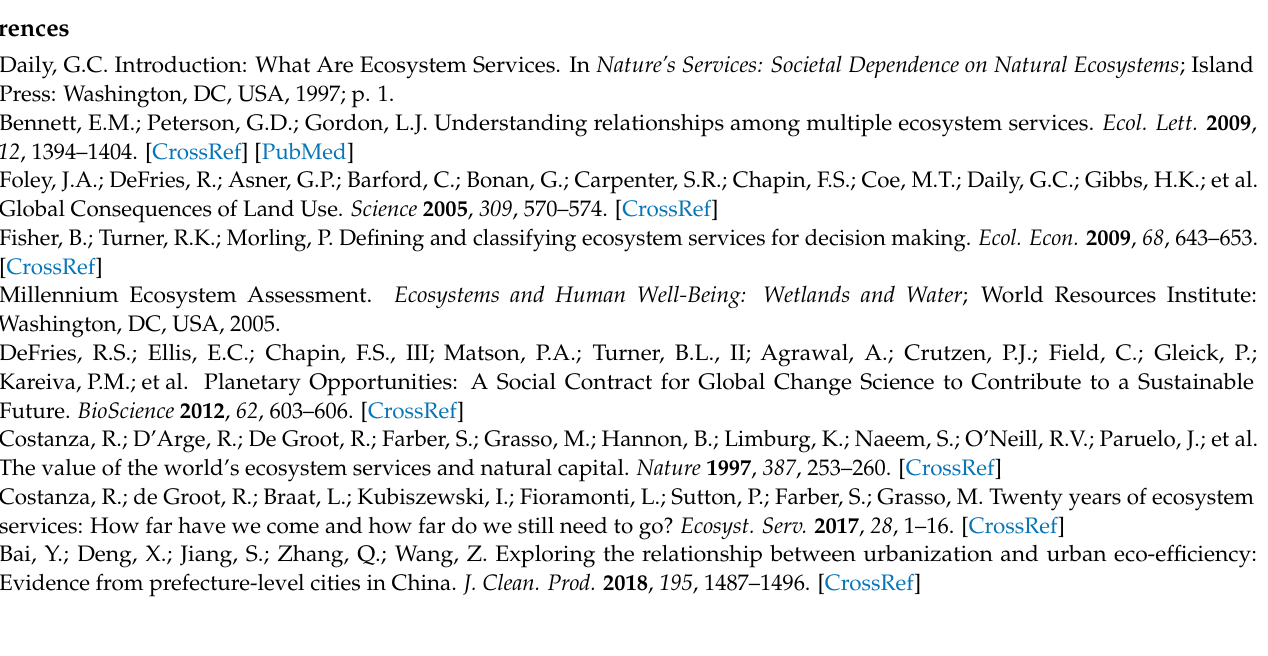
Table S2: The power of q for the 6 factors explaining the trade-offs/synergies between ecosystem services in the LP, 2015; Table S3: Interaction detection between ecosystem services in the LP, 2015. References [65–72] are cited in the supplementary